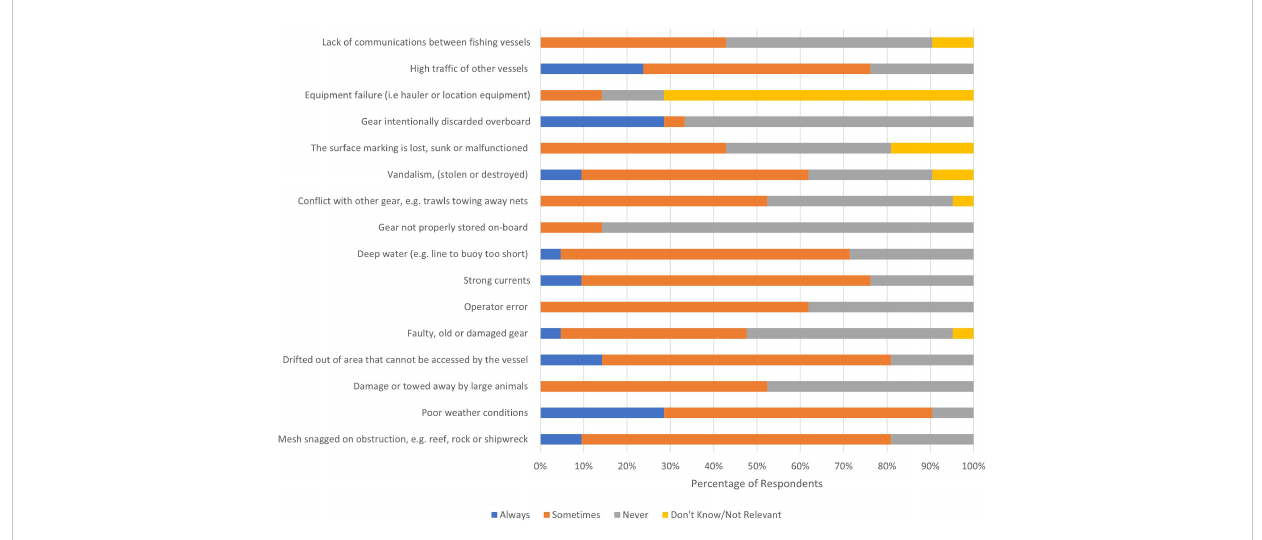
FIGURE 3 Summary of survey results from Dominica to the question: “ When a vessel loses traps, what are the main causes of the gear loss and their corresponding frequency of occurrence? ” (n =